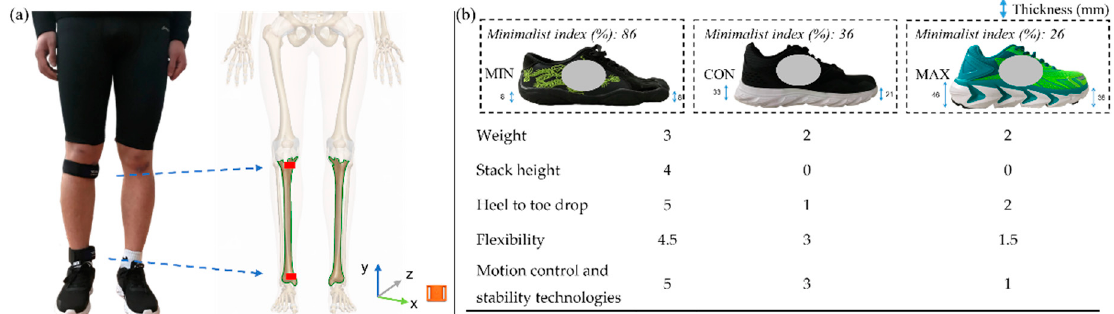
Figure 1. The sensor placement ( a ) and the minimalist index and sub-scores for each item ( b ). Note: MINs: the minimalist shoes; CONs: the conventional shoes; MAXs: the maximalist shoes.